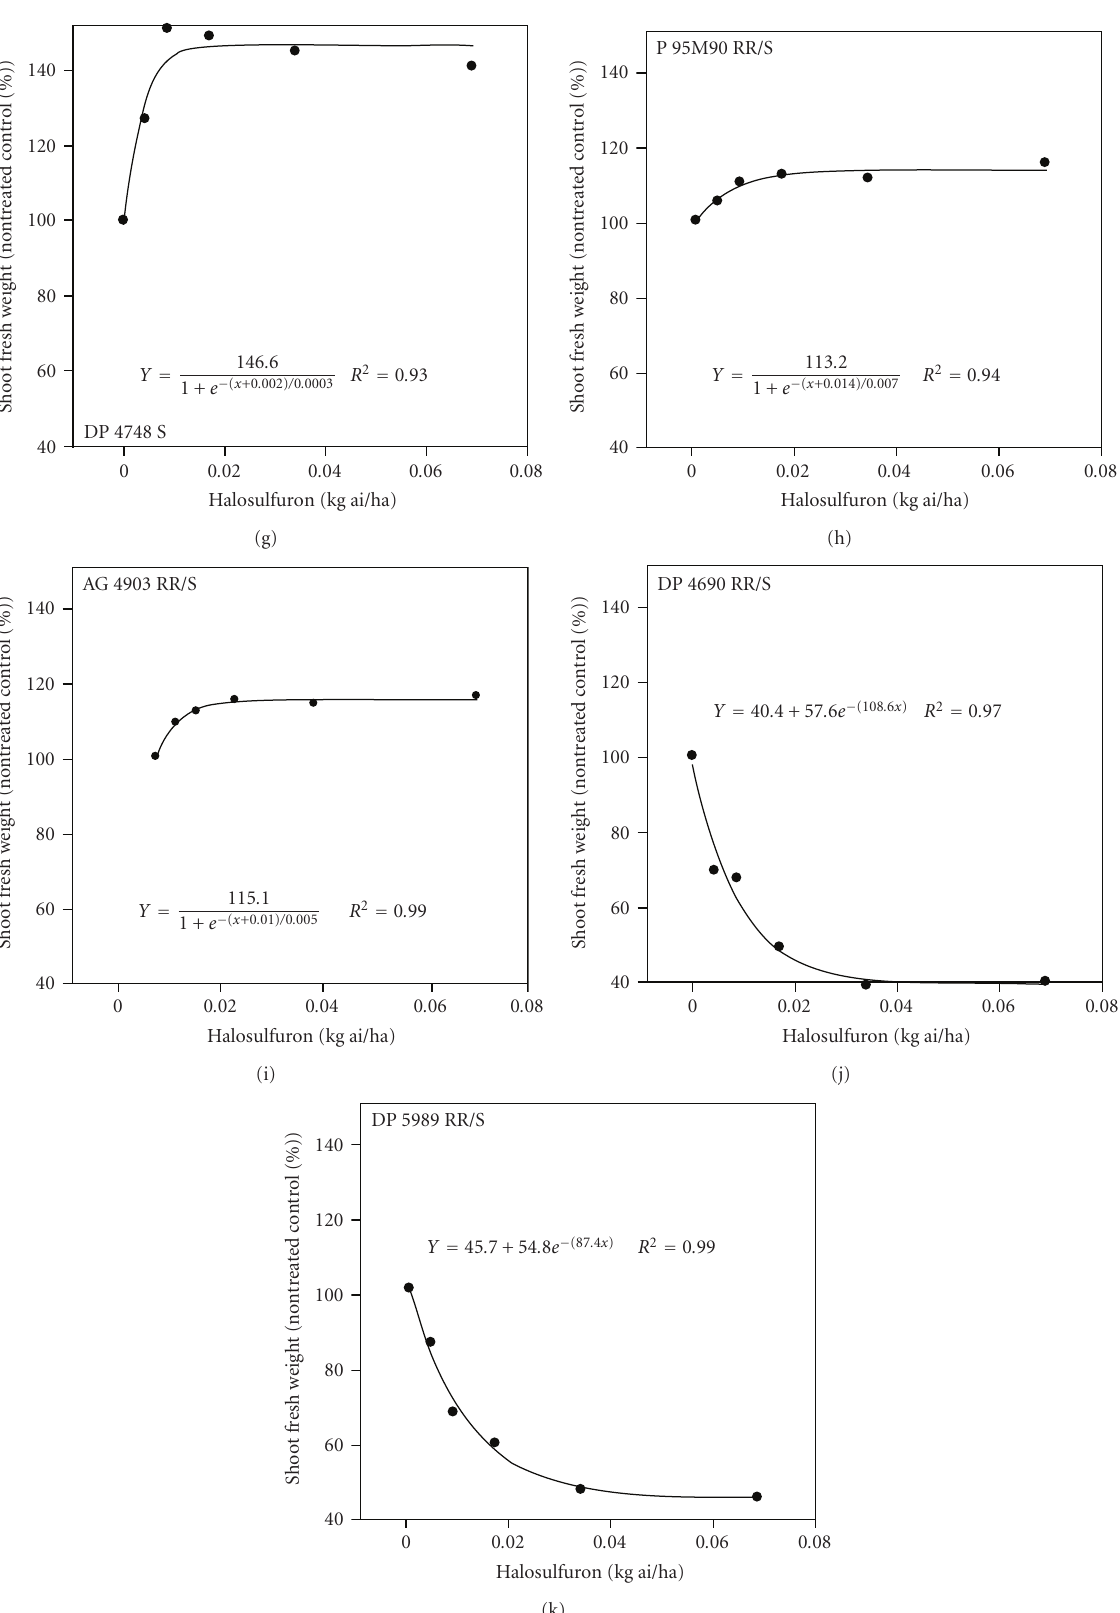
Figure 1: Varietal response of soybean to halosulfuron at 21 days after treatment. Shoot fresh weight expressed as percent of nontreated